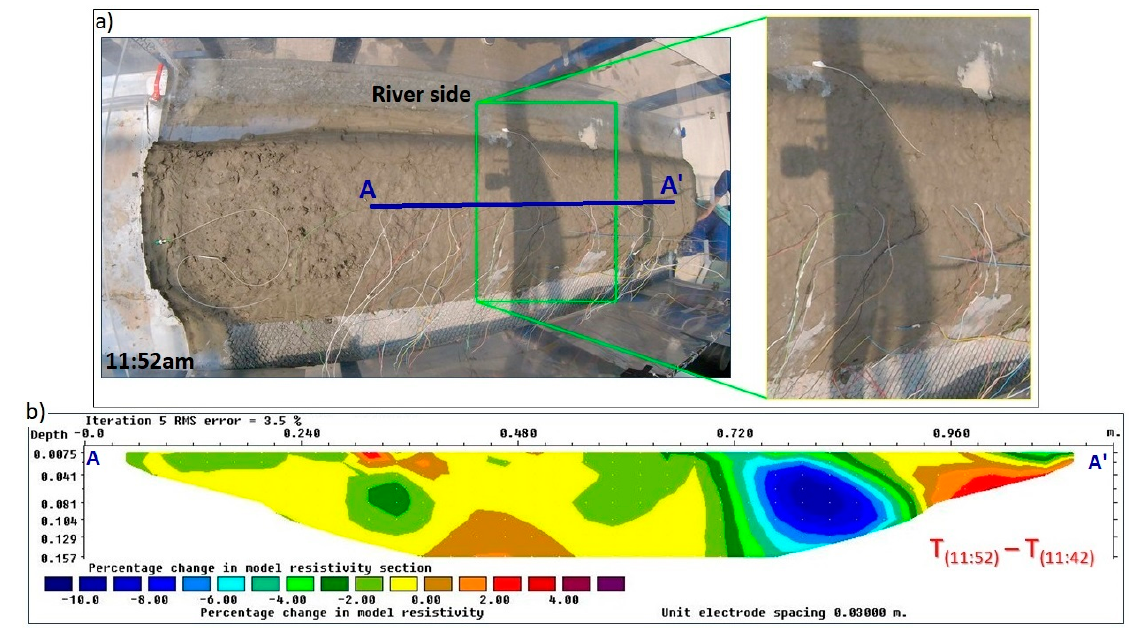
Figure 4. ( a ) GoPro picture for one of the experiments at 11:52 a.m. when water had already entered the wider leakage zone